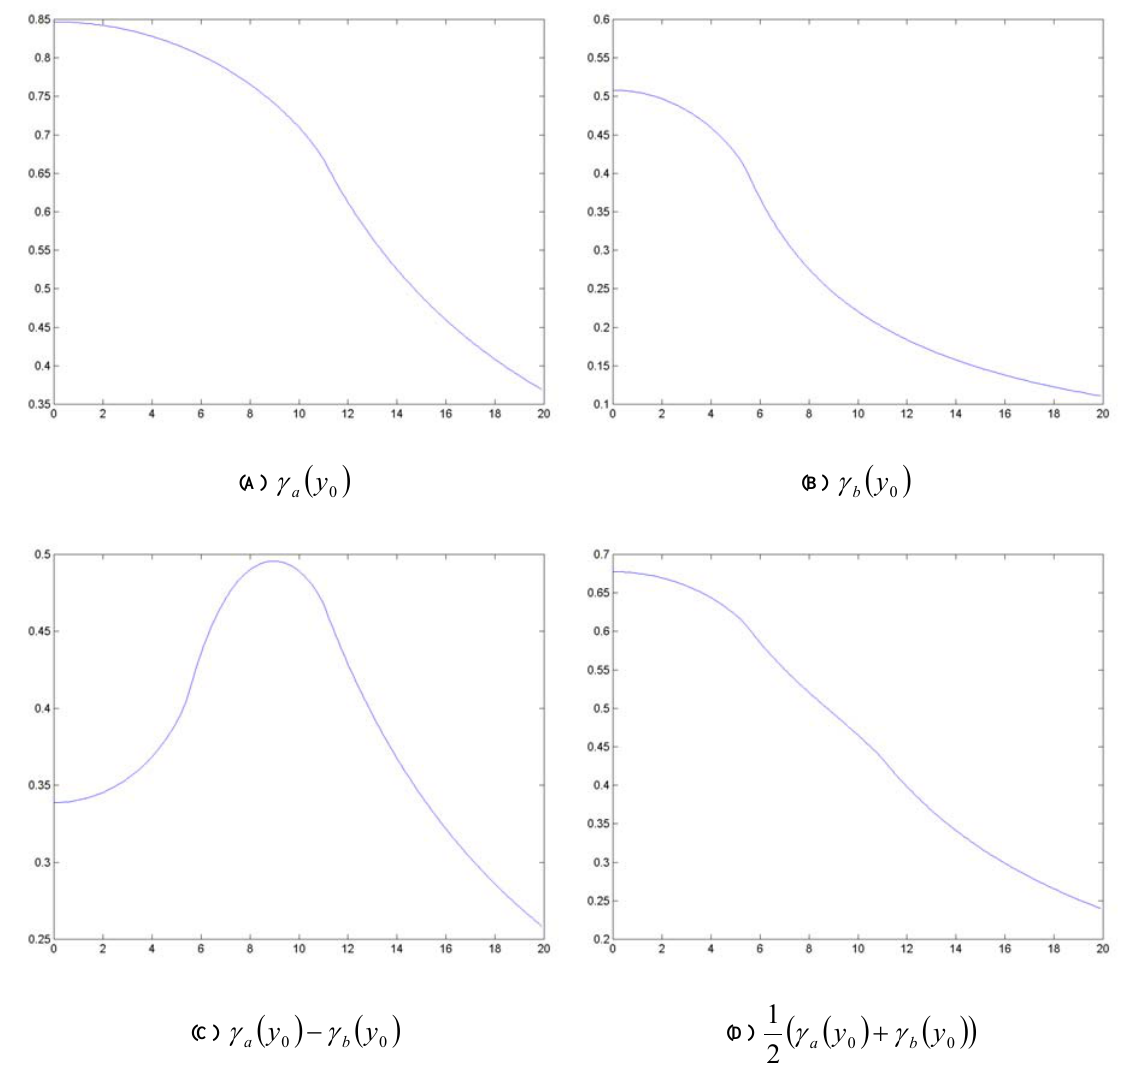
FIGURE 7. The ratios of number of cell pixels to the total in the window. (A) Ratio for goblet cells; (B) ratio for nongoblet cells; (C) the ratio difference between goblet and nongoblet cells; and (D) the average ratio of goblet and nongoblet cells.